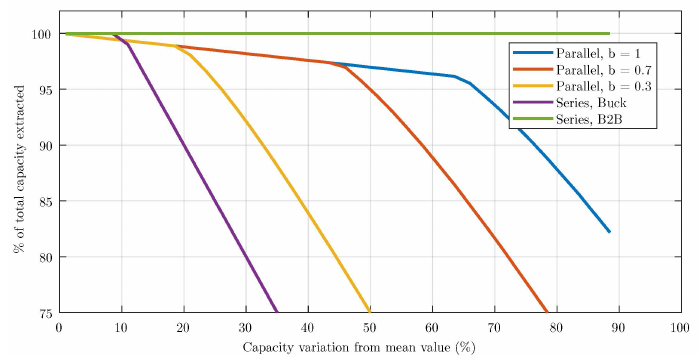
Figure 4. Bank extractable energy depending on the charge distribution and the implementation